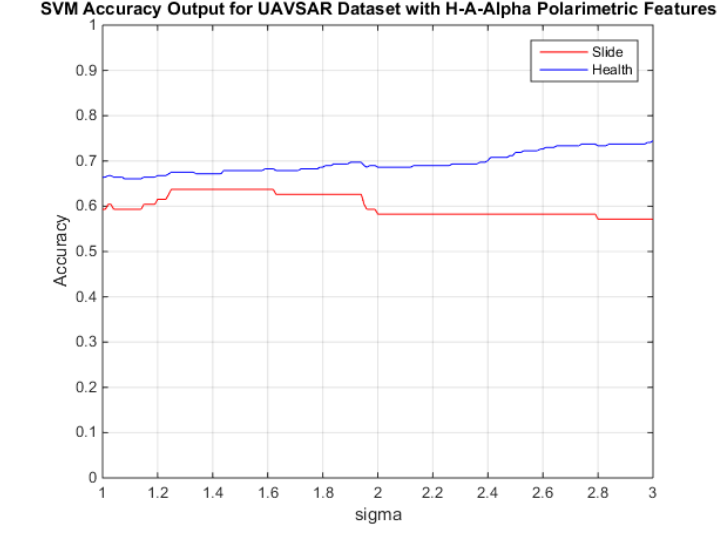
Figure 11. SVM classifier accuracies with polarimetric decomposition feature set ( H , A , and α ) for UAVSAR subset of 16 June 2009 versus σ . The blue line is healthy levee and the red line slump